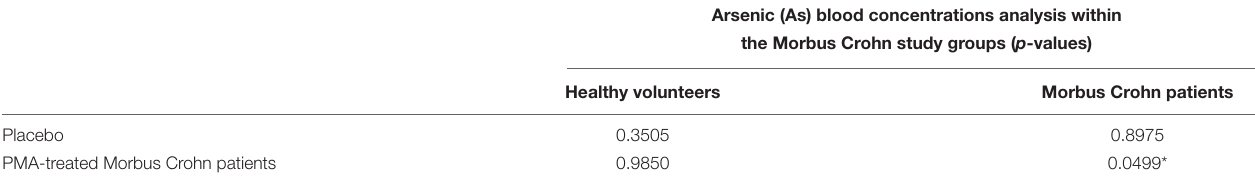
TABLE 6 | Arsenic (As) blood concentrations analysis within the Morbus Crohn study groups.